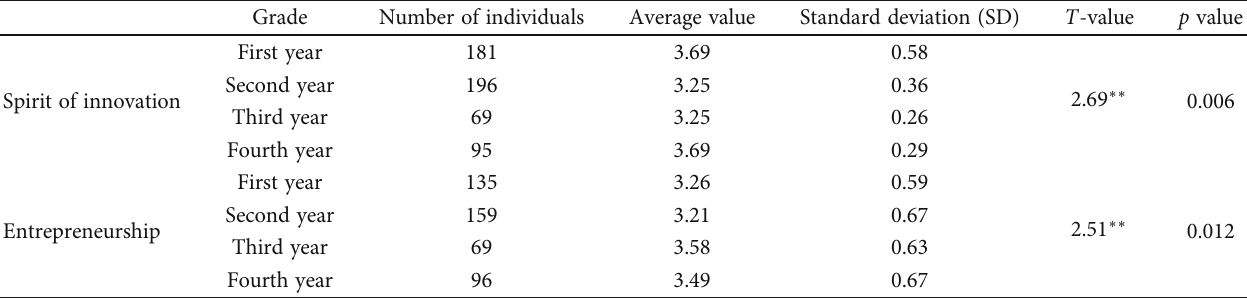
Table 2: Di ff erences in innovation and entrepreneurship by grade type.